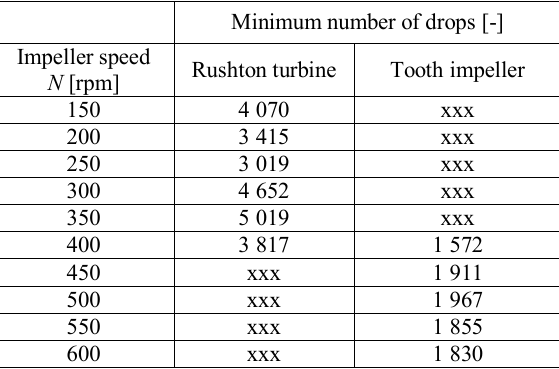
Table 5. Calibration data results for high-shear tooth impeller Calib.